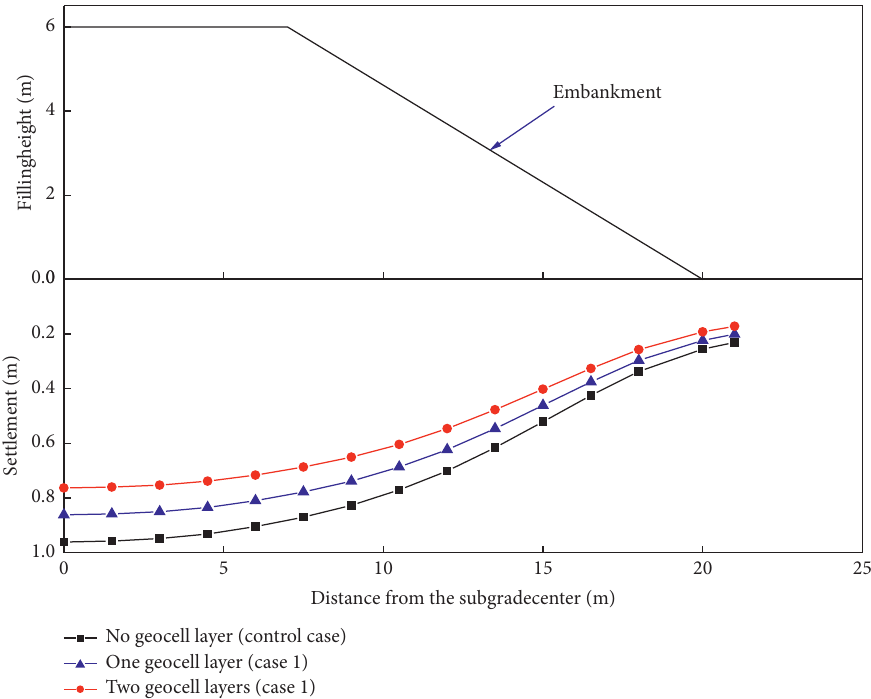
Figure 6: Influence of geocell layer in sand cushion on the differential